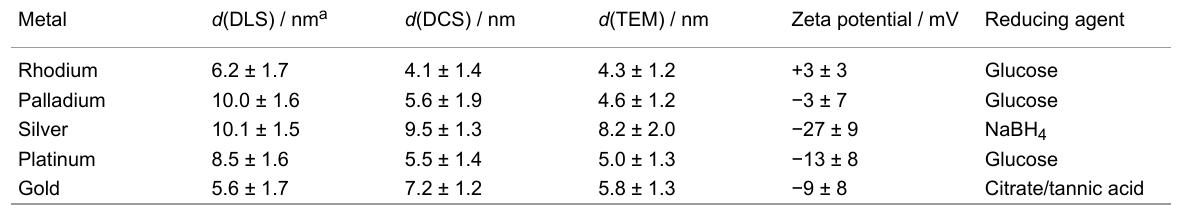
Table 2: Size distribution data of PVP-stabilized noble metal nanoparticles (all nanoparticles were well dispersed in water and not agglomerated). The polydispersity index (PDI from DLS) was between 0.1 and 0.3 in all cases, indicating a good monodispersity.